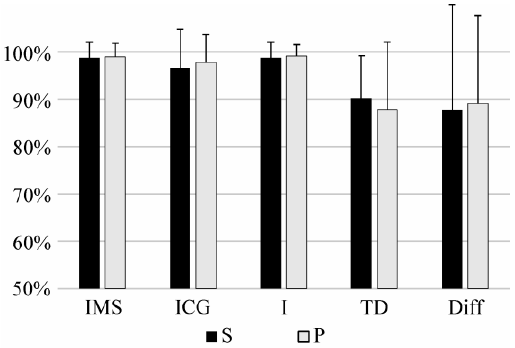
Figure 10. Sensitivity (S) and precision (P) of long-term identification of task using IMS, ICG, I, TD, and Diff features.